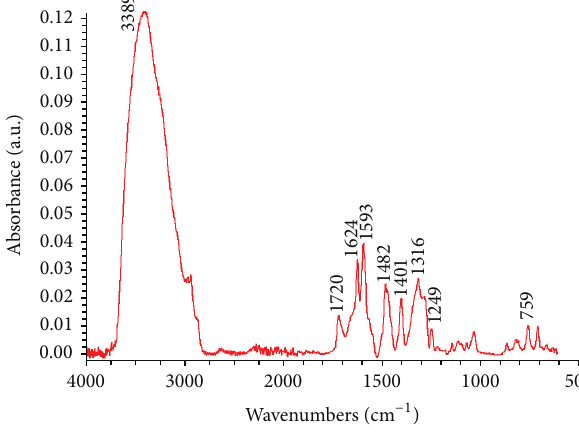
Figure 6: Infrared spectrum (4000–500 cm −1 ) of ASA system via Route 2 (methanol